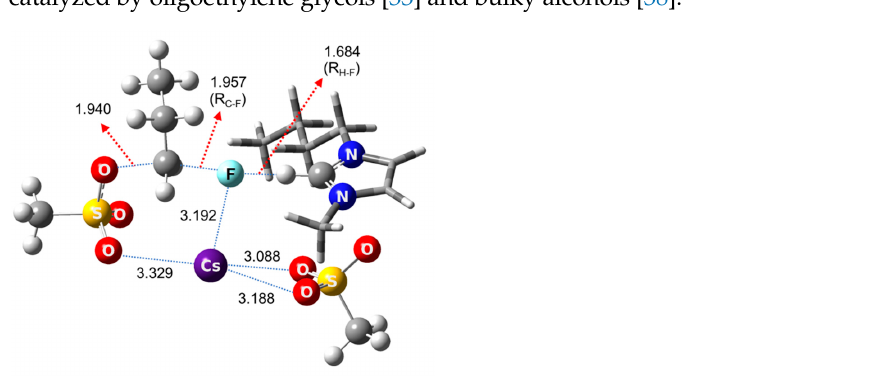
Figure 1. Calculated transition state for S N 2 fluorination using CsF facilitated by